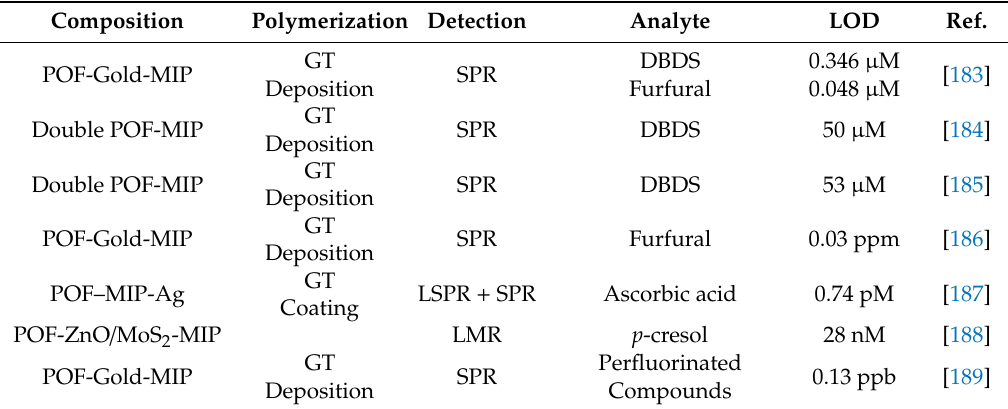
Table 10. Optical sensors based on MIPs deposited on an optical fibre.